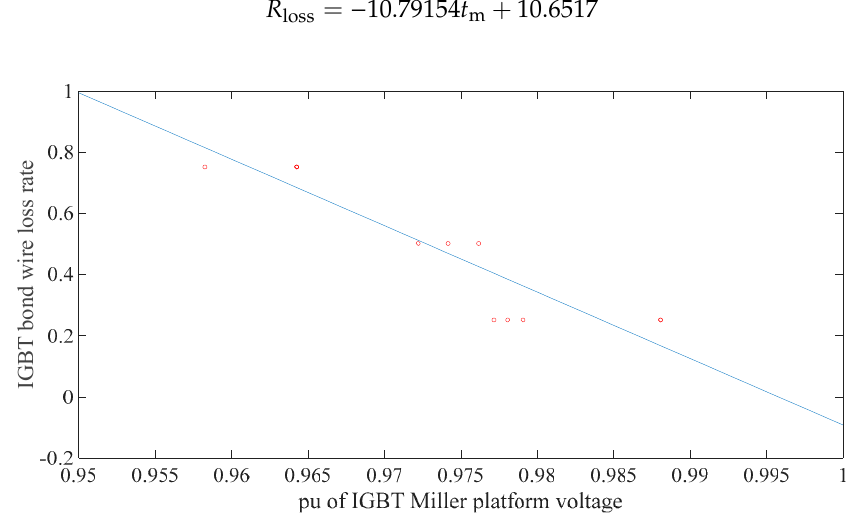
Figure 19. Fitted function between the univariate V m * and R loss.